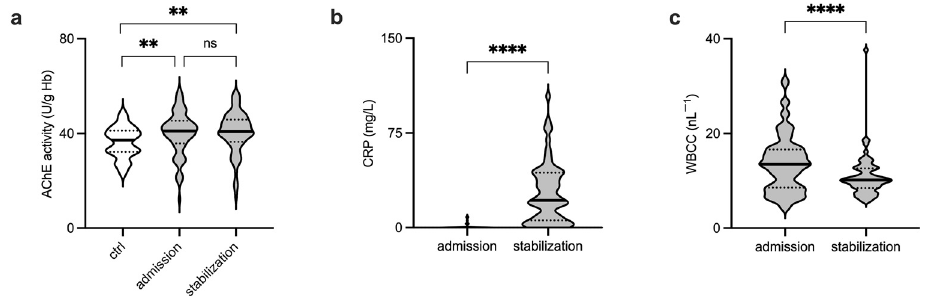
Table 1. Basic demographic data of volunteers as well as demographics and clinical scoring data of the injured patients. * Median with interquartile range.